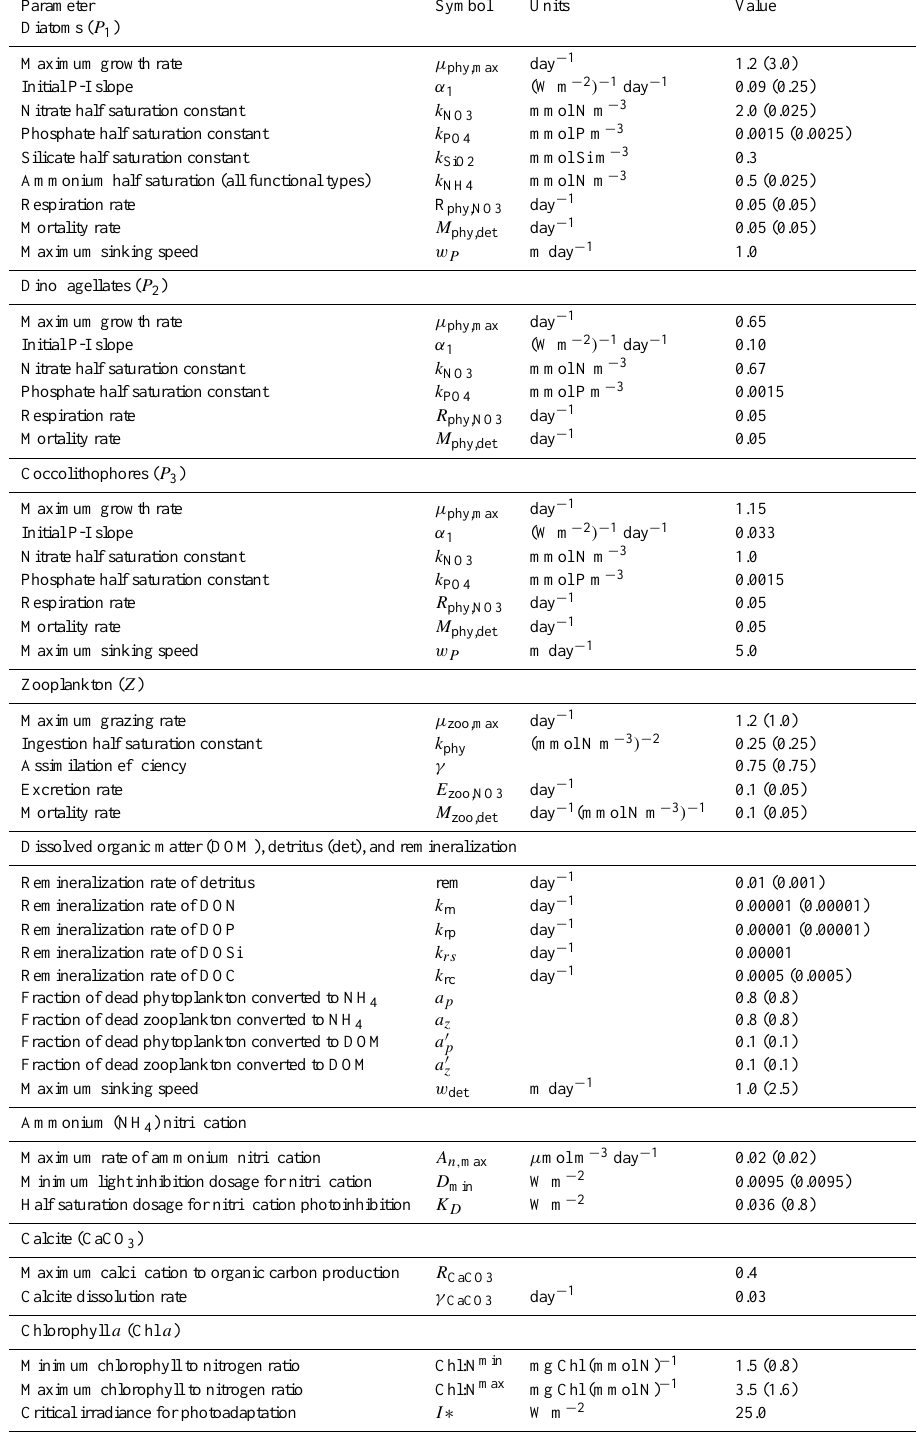
Table B2. Summary of ECO1D-2.0 parameters used in the 1981–2008 simulation for the subpolar North Atlantic. Equivalent parameters used in ECO1D-1.0 for the BATS site are included in parenthesis where appropriate (ECO1D-1.0 combines all phytoplankton into one single group, so phytoplankton-relevant parameters are provided under the diatoms group in this